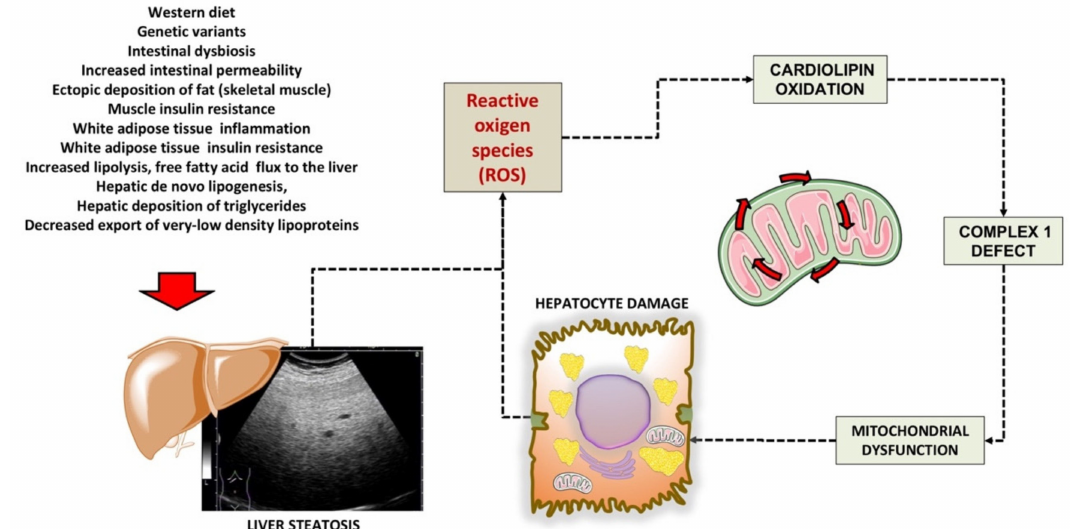
Figure 2. Putative mechanisms of damage involving cardiolipin in liver mitochondria during liver steatosis. Following several predisposing factors, liver steatosis develops. The increased production of ROS is associated with mitochondrial cardiolipin oxidation, defective complex 1, and furthers mitochondrial and hepatocyte dysfunction. Cardiolipin is a phospholipid localized almost exclusively within the inner mitochondrial membrane close to complexes I and III of the mitochondrial respiratory chain. Mechanisms of damage have been elucidated in the study by Petrosillo et al., using the rodent model fed a choline-deficient diet to induce simple liver steatosis